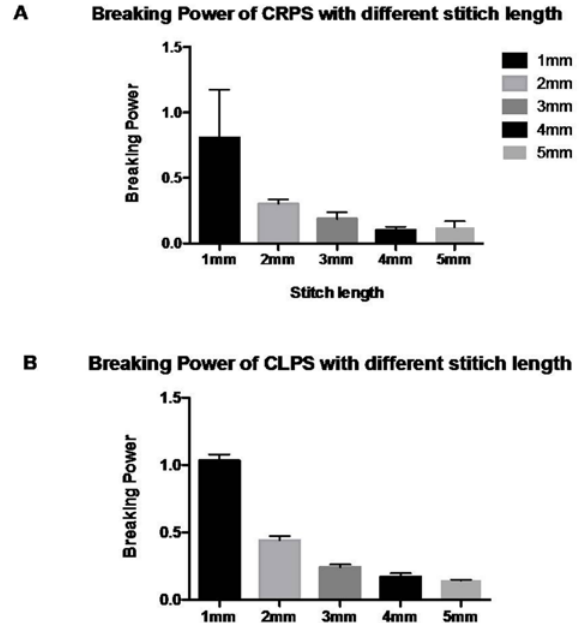
Figure 3: Comparison of Breaking Power of CRPS (A) with CLPS (B) with different stitch